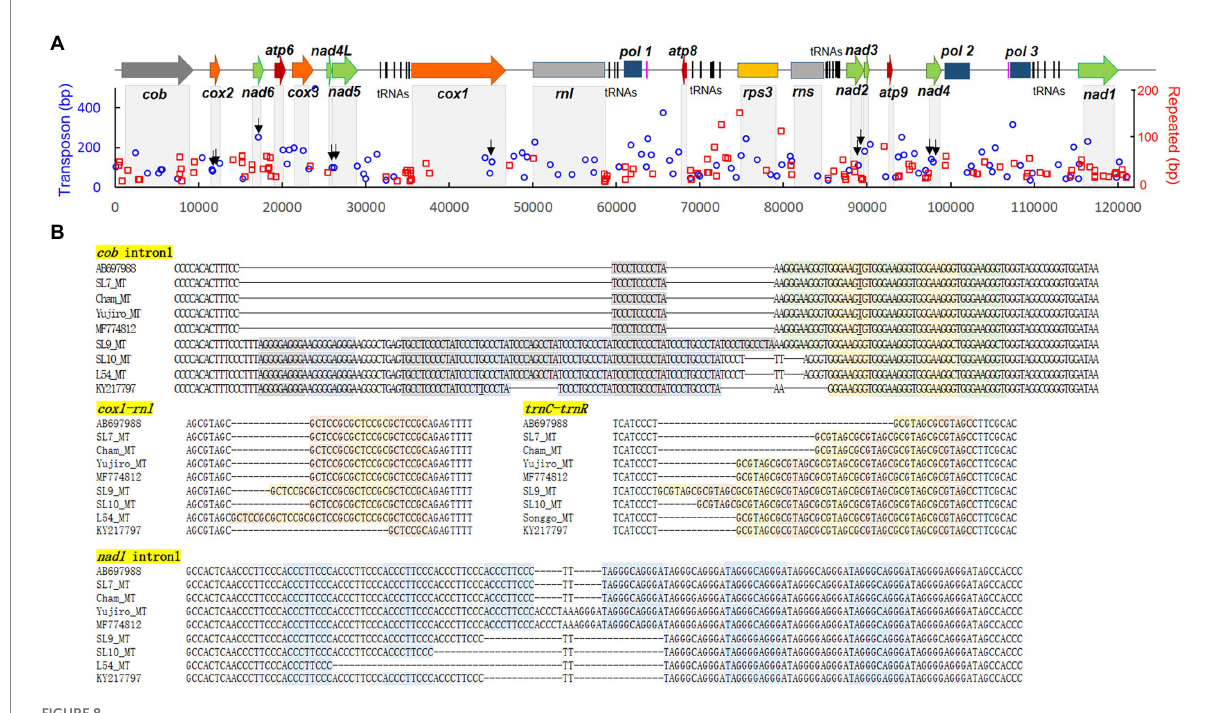
FIGURE 8 Repeated sequences in the mtDNA of L. edodes . (A) Locations of the repeated sequences (red rectangle) together with TEs (blue circle) along with the mtDNA sequence. The axis depicts the length of each TE or repeated sequence. Arrows indicate the positions of TEs in exons. (B) Sequence structure of repeated sequences at various locations in the mtDNA of different strains. The repeating units are colored